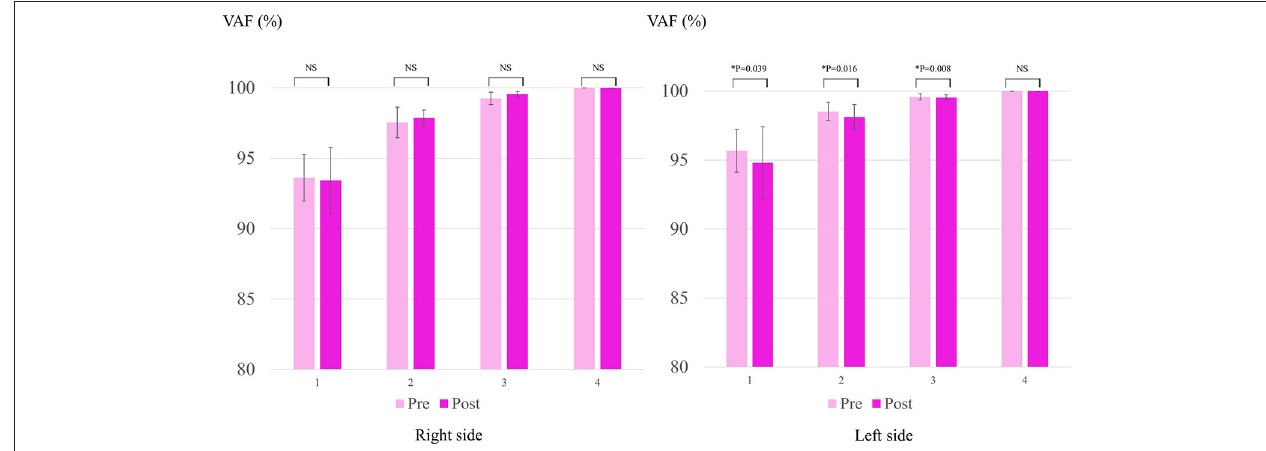
FIGURE 5 | Change in VAF (variance accounted for) in Case 2. Y-axis shows VAF (%).